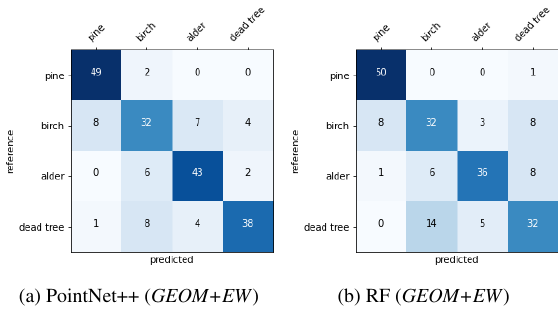
Figure 7. Confusion matrices on the test dataset using only geometry information and EW values.